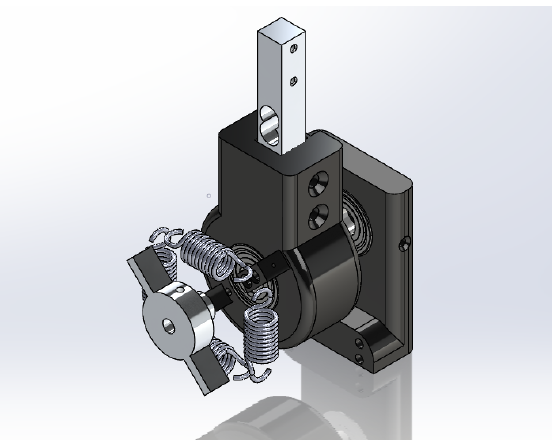
Figure 5. Hardware Diagram.